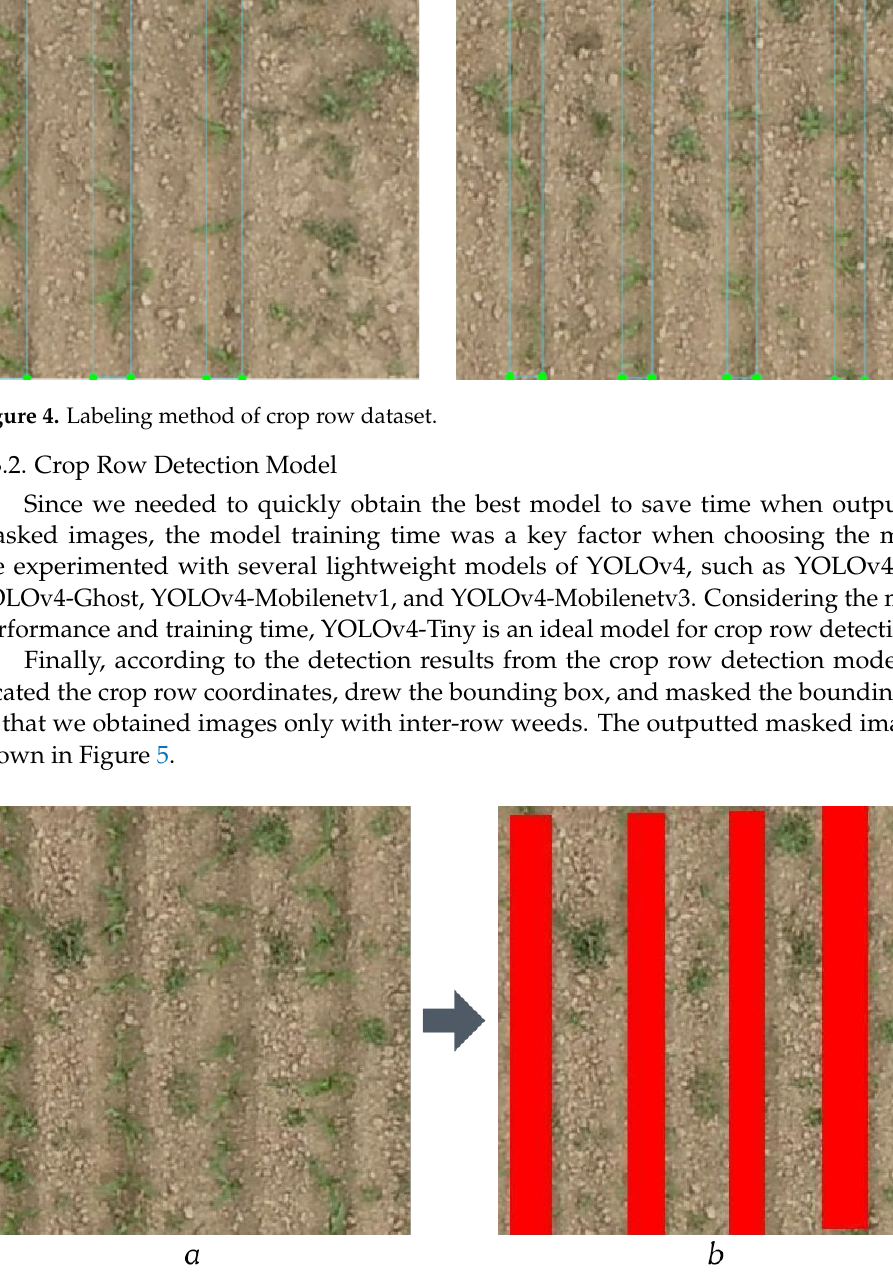
Figure 5. ( a ) The image inputted into the crop row detection model, and ( b ) the masked image out- putted by the crop row detection